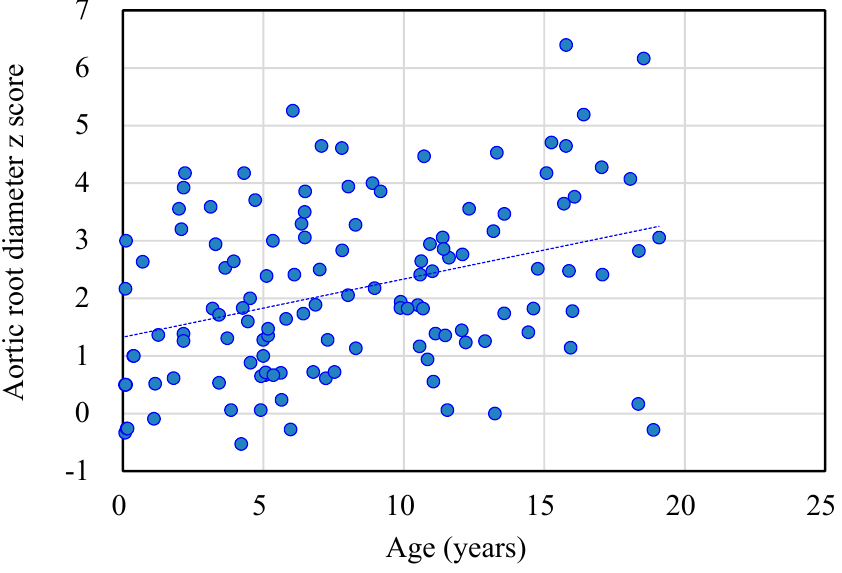
Figure 2. The aortic root diameter z score was positively correlated with age in the 125 patients with MPS ( r = 0.353, p < 0.01). The dotted line represents the trendline.